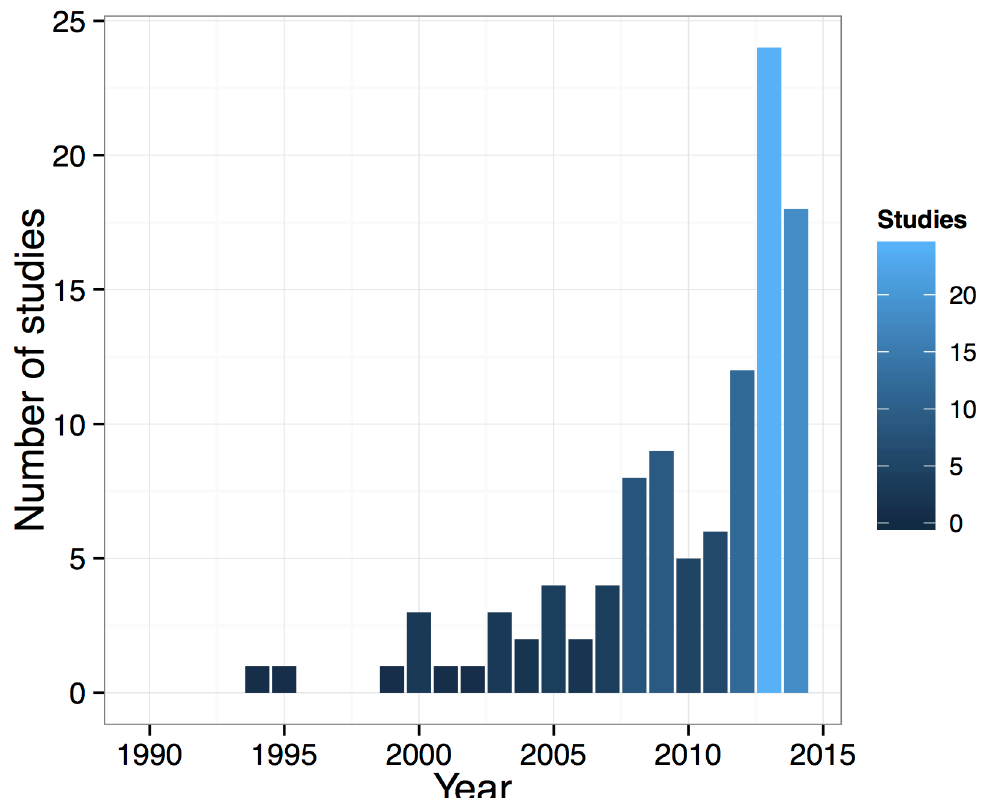
Fig 2. Annual number of studies of aquatic vertebrates from 1990 to 2014. The color gradient is proportional to the number of studies in each year.